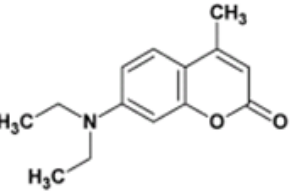
Figure 8. Coumarin 1, fluorescent compound and inhibitor reported by Simonian’s